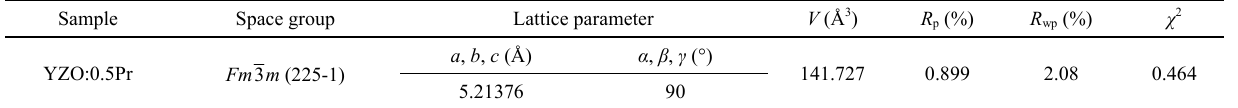
Fig. 2 (a, b) XRD patterns and Rietveld refinement XRD patterns of representative YZO:0.5Pr sample, respectively. (c, d) SEM image and corresponding element mappings of the calcined powder and sintered ceramic, respectively. Note: RT in (a) represents room temperature. Table 1 Structural refined results of YZO:0.5Pr